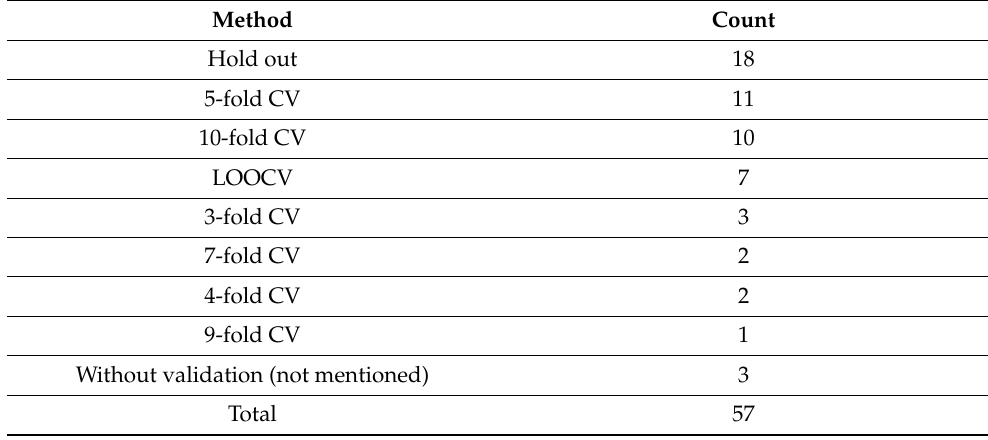
Table 3. Total number of studies according to the type of validation method